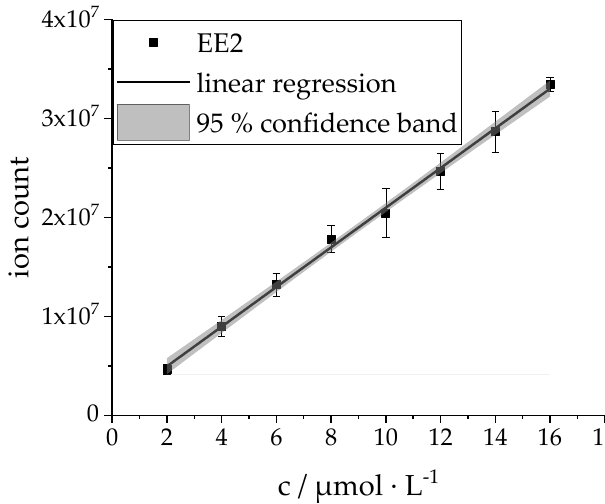
Figure 1. Calibration curve formed by gas chromatograph-mass spectrometry (GC-MS) measurements of eight calibration standards ranging from c = 2 µ mol · L − 1 to c = 16 µ mol · L − 1 , with an increment of ∆ c = 2 µ mol · L − 1 ; quintuple determination; slope:2003070 L mol − 1 , point of intersection with the ordinate:971408.3; ion counts determined by the integration of the respective EE2 signal in the obtained EIC chromatograms (EIC = extracted-ion current; precursor ions: 440 m / z, 425 m / z, 285 m / z); the concentration values given are a representation of the EE2 concentration in aqueous solution during catalytic screening experiments. Table 1. Values for process standard deviation (PSD), limit of detection (LOD) and limit of quantita- tion (LOQ); referring to Figure 1; according to DIN 32645.